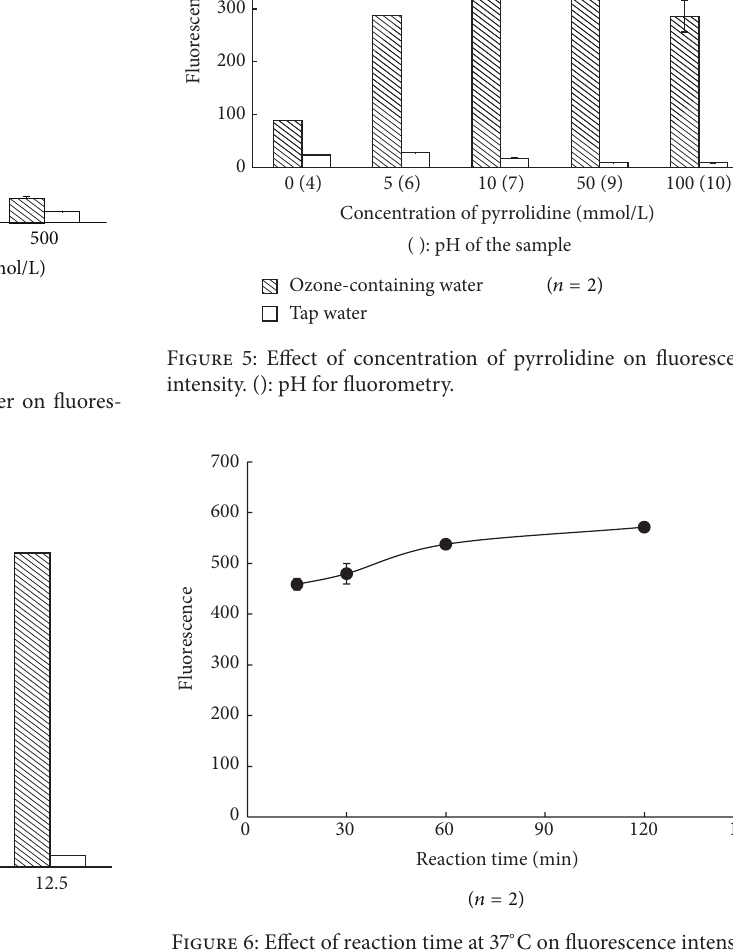
Figure 6: Effect of reaction time at 37 ∘ C on fluorescence